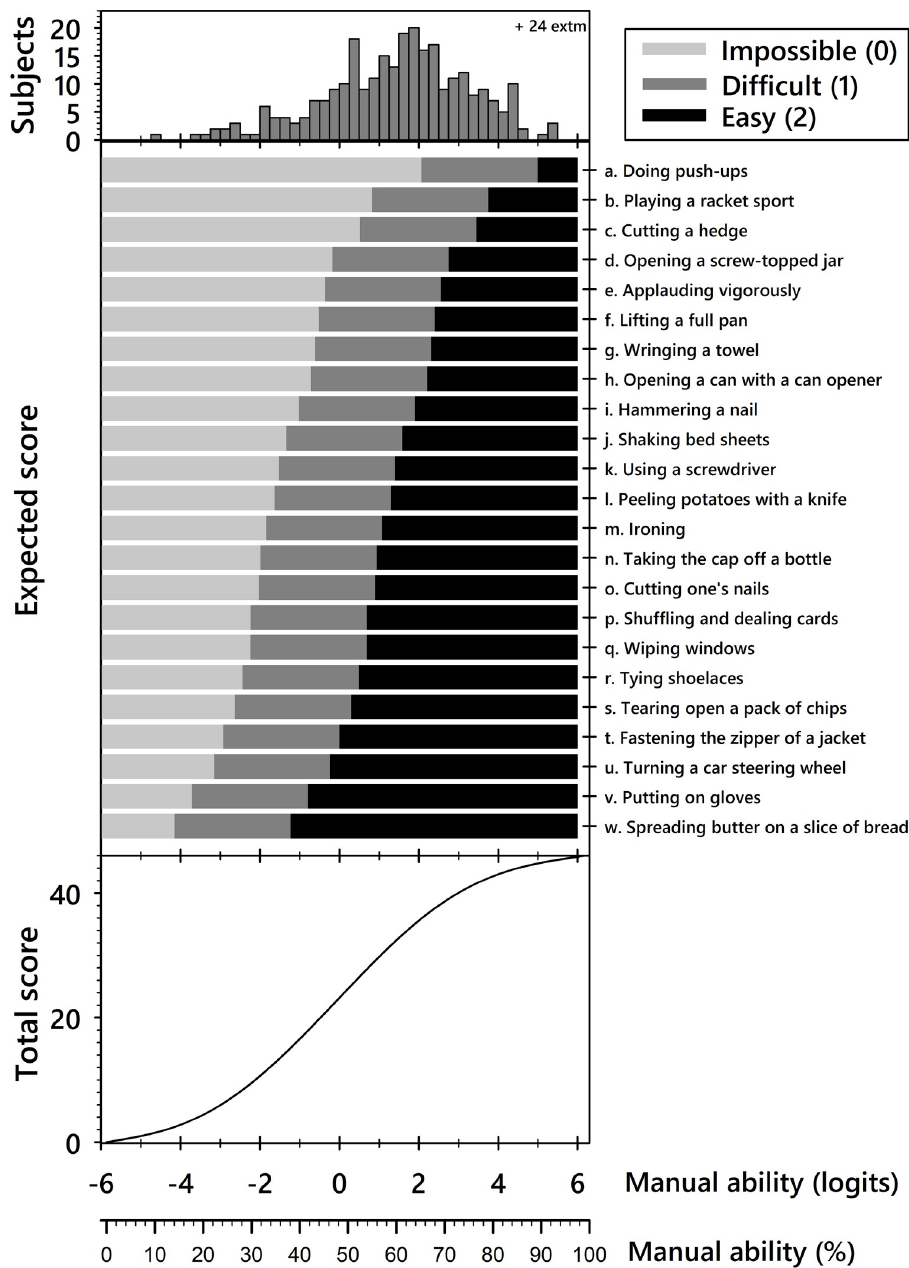
Fig 2. Structure of the ABILHAND-HS scale. Top: distribution of manual ability measures for the whole sample expressed in logits (log of the pass/fail probability ratio) and centiles (fraction of the measurement range). Twenty-four patients (7.9%) were able to perform all 23 activities easily, and were thus identified as extreme patients. None of the participants reported that they could not perform any of the 23 activities. Middle: most probable patient response to each item based on the patient manual ability and on the difficulty of the item’s response category. The average item difficulty was set to 0 logits and the items are ordered from most (top) to least (bottom) difficult. The distance between thresholds (middle bar) is constant for all items (2.93 logits or 24 centiles). A patient with a manual ability measure of 0 logits would be expected to perform the first 3 activities easily, to have some difficulty with the following 17 activities, and to be unable to perform the 3 most difficult activities. A patient with a measure of 2.1 logits should be able to perform all activities easily or with some difficulty. Bottom: conversion of ordinal raw scores into a linear continuum of manual ability for complete response sets. The raw scores ranged from 0 to 46 (sum of scores of 0–2 for 23 items). This curve is linear in its central (30 th ~70 th percentile) range, with sigmoid flattening outside the central range, highlighting a non-linear relationship, especially at the extremities of the score